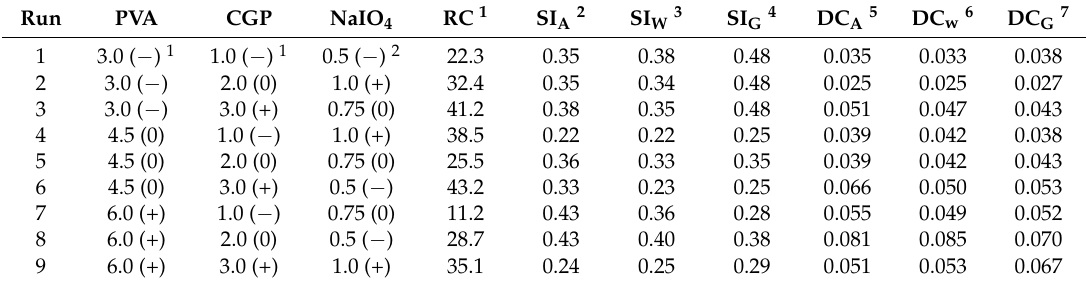
Table 2. Results for the content of released carbohydrates, swelling properties and dimensional changes from CGP/PVA films produced in the 3 3-1 fractional factorial design.